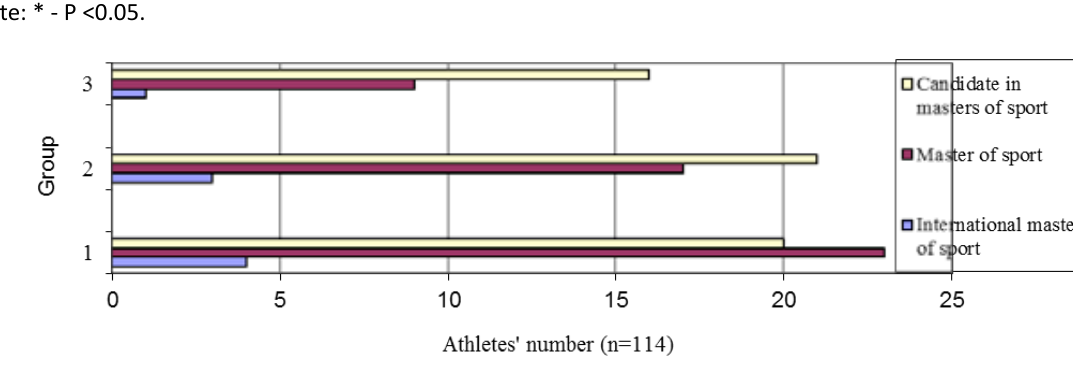
Fig. 1. Data on sports qualifications of athletes in the studied groups.